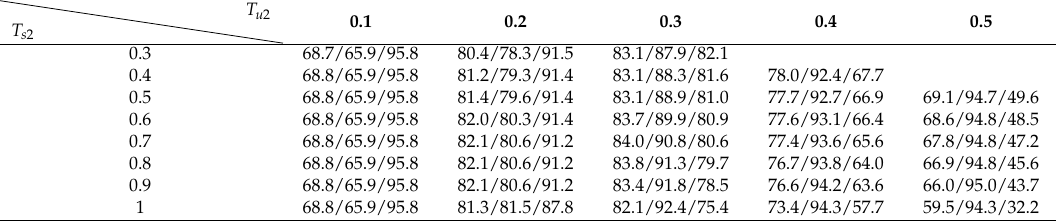
Table 3. Overall accuracy (%)/user’s accuracy (%)/producer’s accuracy (%) as a function of T s 2 and T u 2 . T s 2